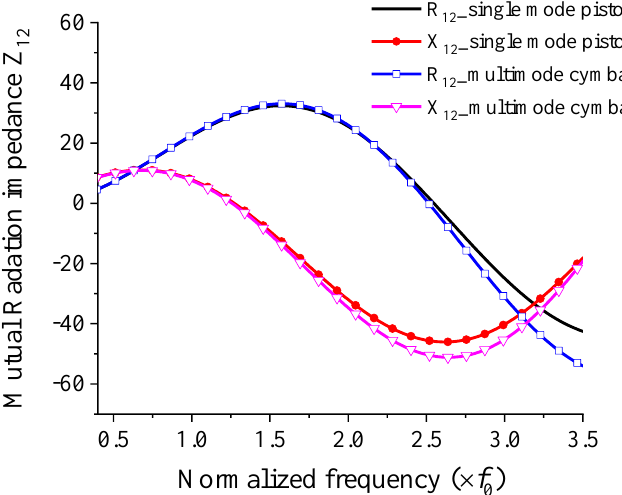
Figure 6. Comparison of the mutual radiation impedances of a single–mode piston source and muti–mode cymbal transducer; R 12 = resistance, X 12 = reactance.